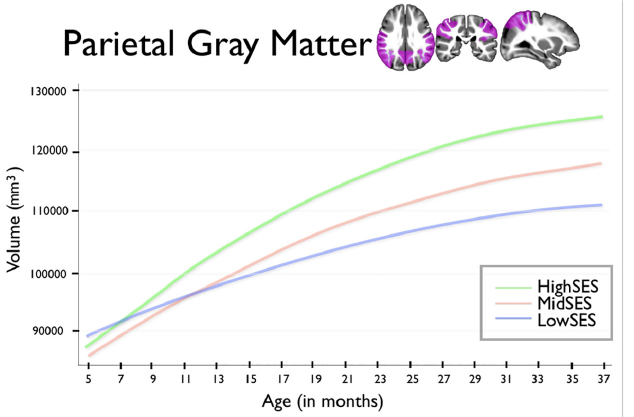
Fig 4. This figure shows parietal lobe gray matter volumes for group by age. Age in months is shown on the horizontal axis, spanning from 5 to 37 months. Total gray matter volume is shown on the vertical axis. The blue line shows children from Low SES households; children from Mid SES households are shown in red. The green line shows children from High SES